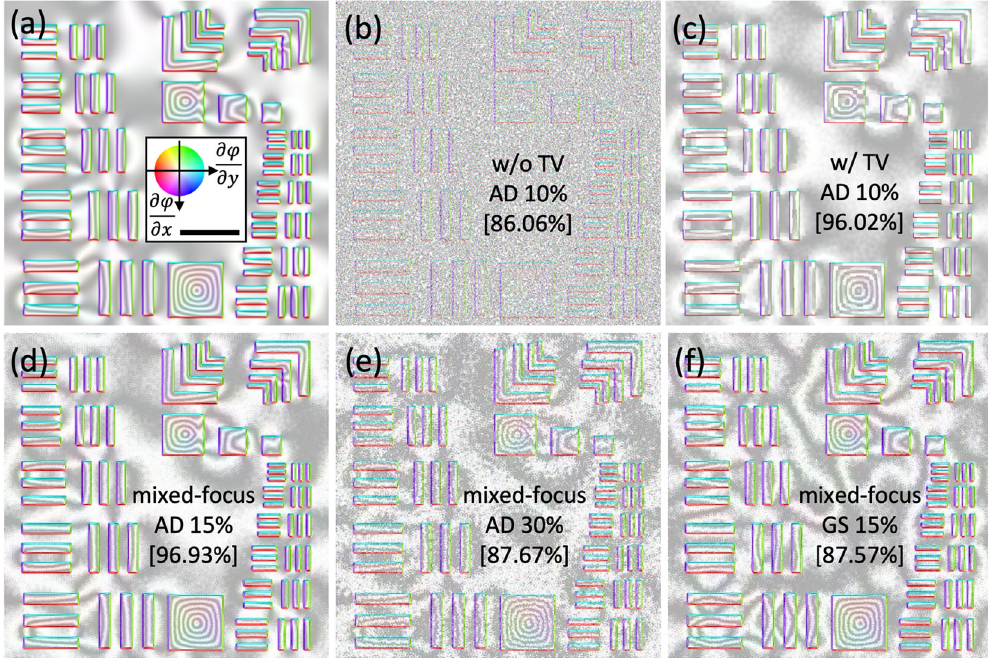
Fig. 3 Comparative performance in the presence of simulated noise. a Ground truth for the phase gradient. Its direction is shown in false color as de fi ned by the color wheel in the inset. Its magnitude is indicated by the gray contour which appears each time the phase wraps over one tenth of 2 π . The scale bar is 500 nm. AD retrieved phase gradient using an image pair with 10% of Gaussian noise at Δ f = ±1.6 mm, ( b ) without and ( c ) with a TV regularizer. The regularization parameter was 4 × 10 − 8 . AD retrieved phase gradient using a mixed focus series consisting of four images ( Δ f = ±0.15 and ±1.6 mm) with ( d ) 15% and ( e ) 30% of Gaussian noise. f GS retrieved phase gradient using the same condition as ( d ). The numbers in the brackets denotes the accuracy of the retrieved phases. The scale bar and the color wheel apply to all the